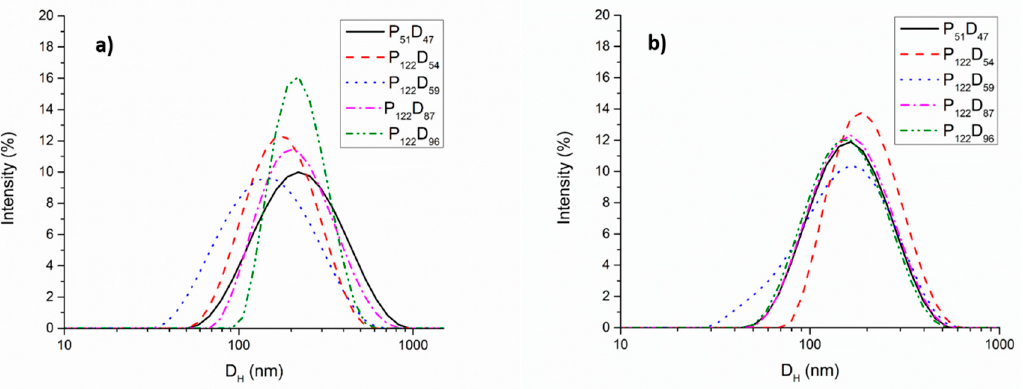
Figure 3. DLS distribution of sizes for the polymer aggregates obtained by: ( a ) direct dispersion in water, and ( b ) solvent exchange or nanoprecipitation.